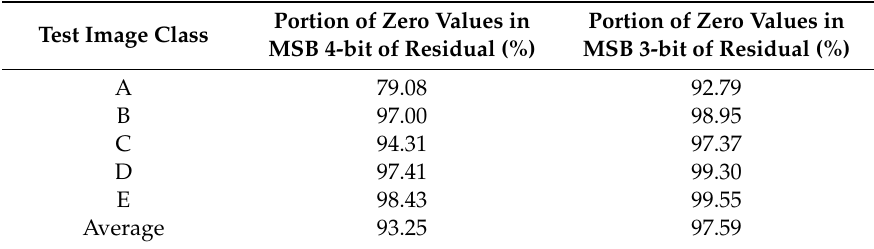
Table 5. Portion of zero values in most significant byte (MSB) of residual.